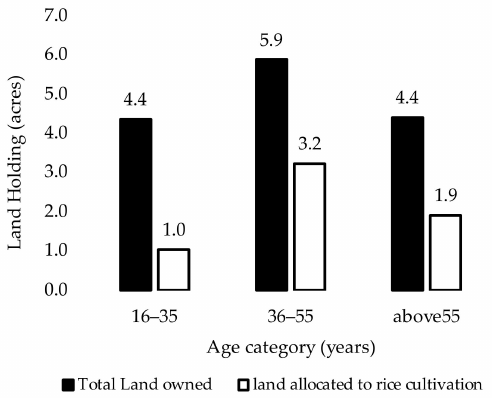
Figure 3. Average land allocation to rice as a proportion of the total arable land owned by the